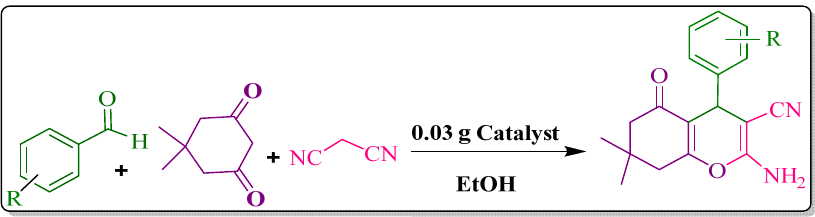
Figure 9 . Preparation of 4 H -benzo[b] pyrans.